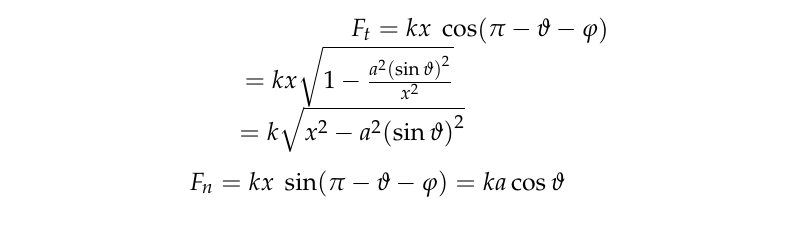
Figure 3. Single DOF link, no longer balanced due to the added payload ∆𝑚 .